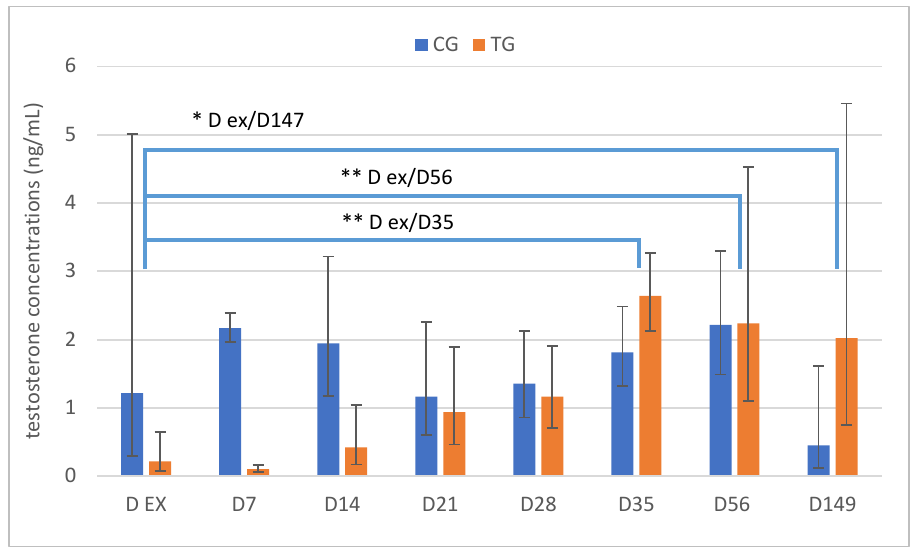
Figure 9. Plasma testosterone concentrations over time in ng/mL given as geometric mean (x ̅ g ) and scatter range whose limits are defined by x ̅ g x dispersion factor ± 1; * p < 0.05, ** p < 0.01; animals treated with a 4.7 mg deslorelin implant (TG, n = 6), and saline-treated, control animals (CG, n = 3).